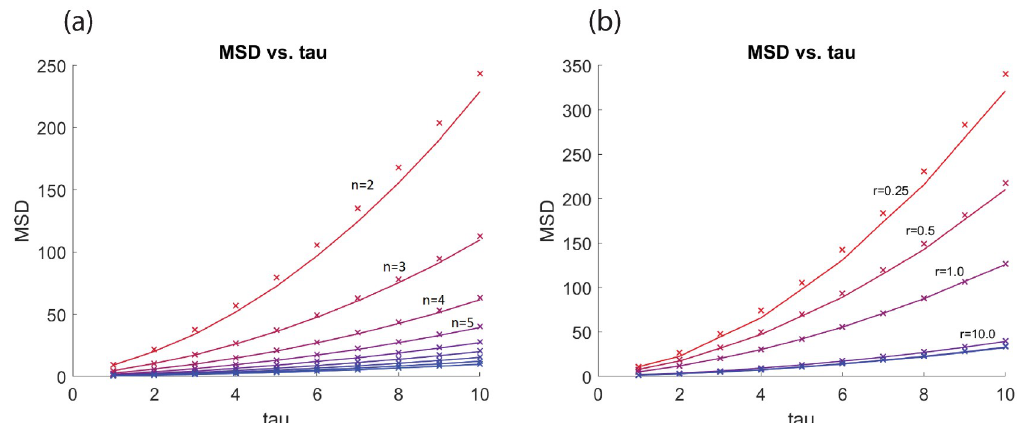
Fig 7. MSD as a function of tau. Panel (a) visualizes the numerical ( TAMSD 2 ) and theoretical (AMSD) results of the MSD versus tau for different values of n (2–10), the total number of FAs, and r = 10. Panel (b) shows simulations where r varies from 0.25, 0.5, 1, 10, 50, and 100 with n = 5. The lines represent the relationship between tau and TAMSD 2 . The “x” uses the AMSD (Eq (13)) and expectation (Eq (7)) to compute the MSD in Eq (4) for different values of tau. There were 1,000,000